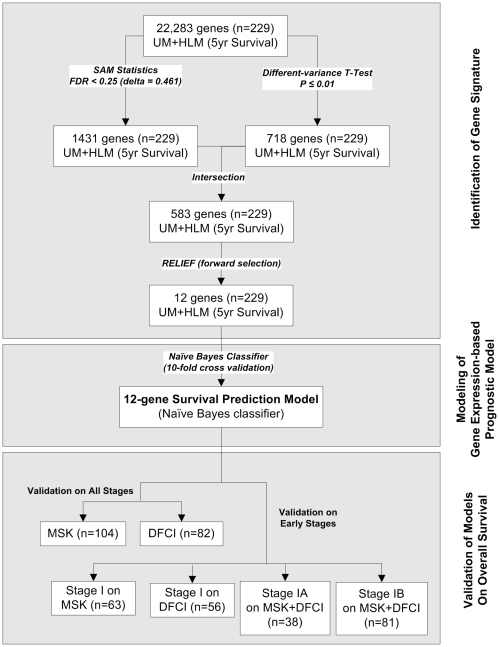
Overview of the study design for the identification of the 12-gene signature with combinatorial gene selection scheme and the construction of the expression-defined prognostic model.